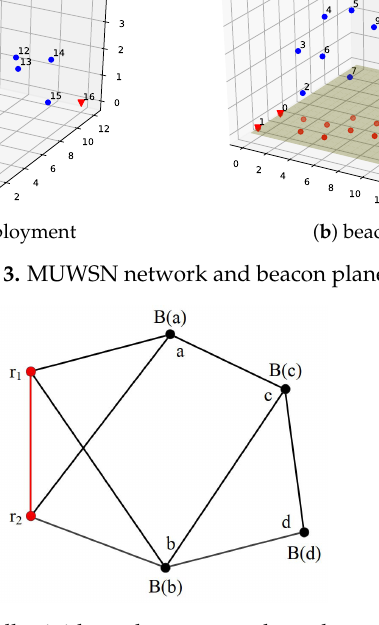
Figure 4. A globally rigid graph constructed step by step using